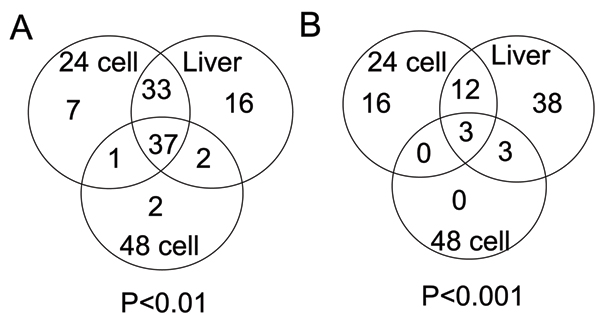
Common KEGG pathway terms among all doses of exposed primary hepatic cells and liver tissue. Numbers represent pathways common to respective cells or tissue. 24 cell = 24 hr exposed cells, 48 cell = 48 hr exposed cells, and Liver = liver tissue. A. ANOVA analysis (p < 0.01). B. ANOVA analysis (p < 0.001).